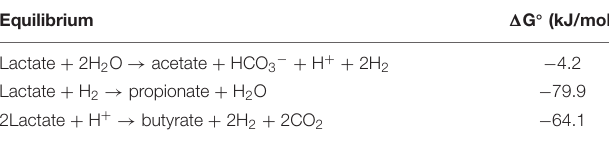
TABLE 4 | Gibbs’s energy of lactate converted to acetate, propionate and butyrate. Equilibrium (cid:49) G ◦